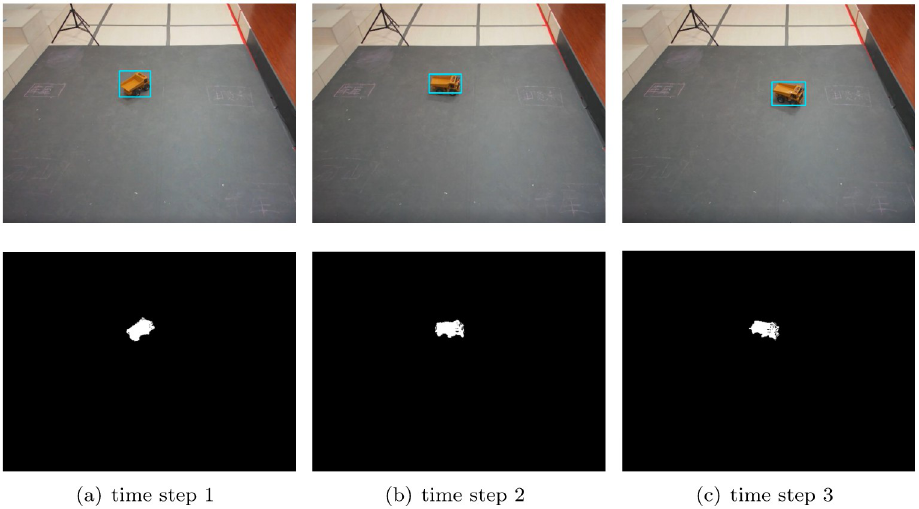
Fig 7. Shadow removal results at different time steps with our DC-SR method under real-time monitoring, when object turns. (a) time step 1. (b) time step 2. (c) time step